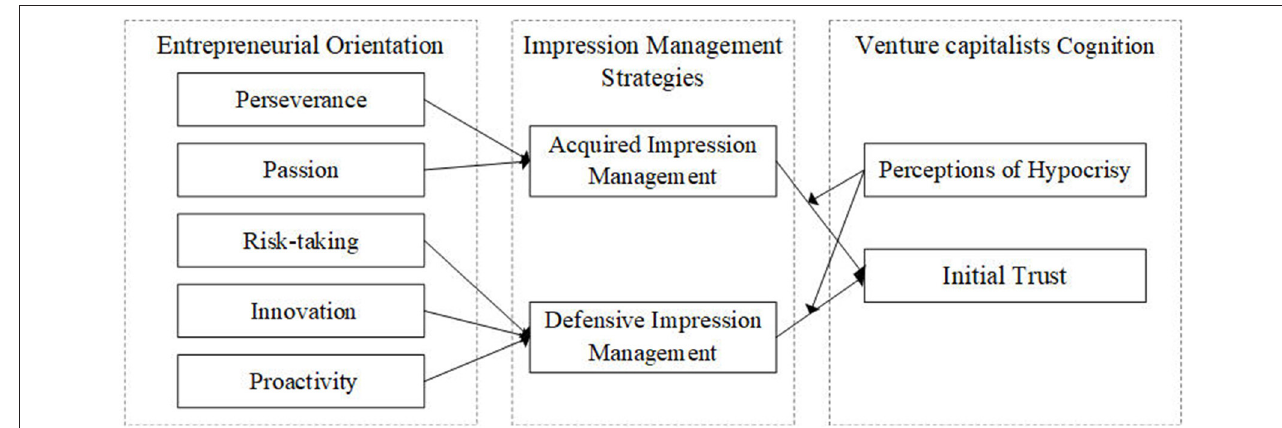
FIGURE 1 | Theoretical